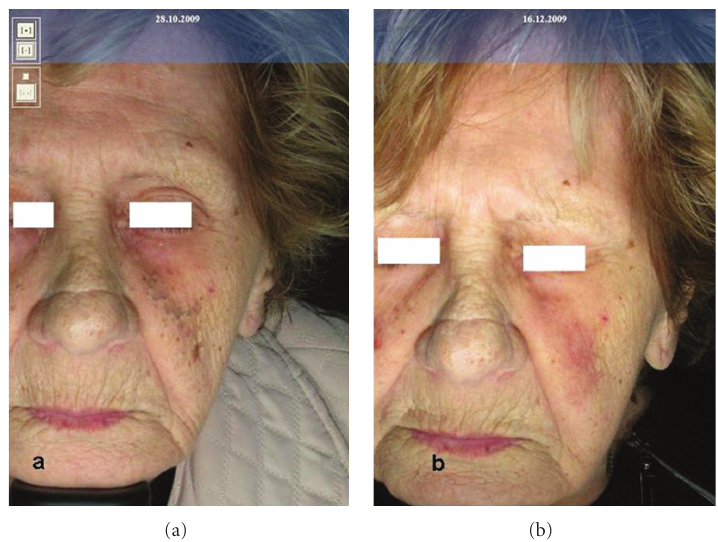
Figure 5: Favre-Racouchot’s disease at first (a) and after (b) one treatment with CO 2 laser.